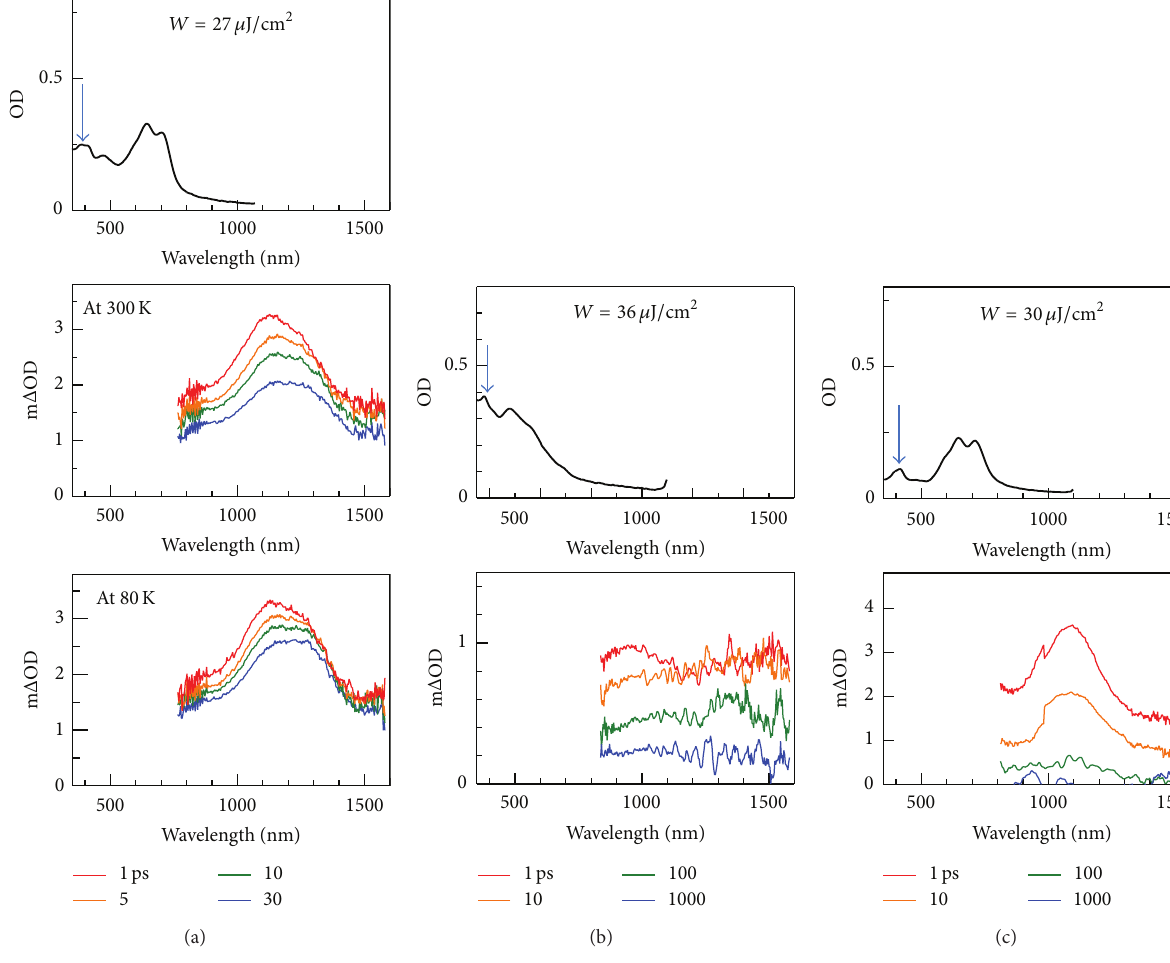
Figure 15: Δ OD spectra of (a) SMDPPEH/PC 71 BM blend, (b) PC 71 BM neat, and (c) SMDPPEH neat films. Top panels show optical density (OD) of the films at 300 K. Downward arrows represent the wavelength of the pump pulse. The data were replotted from